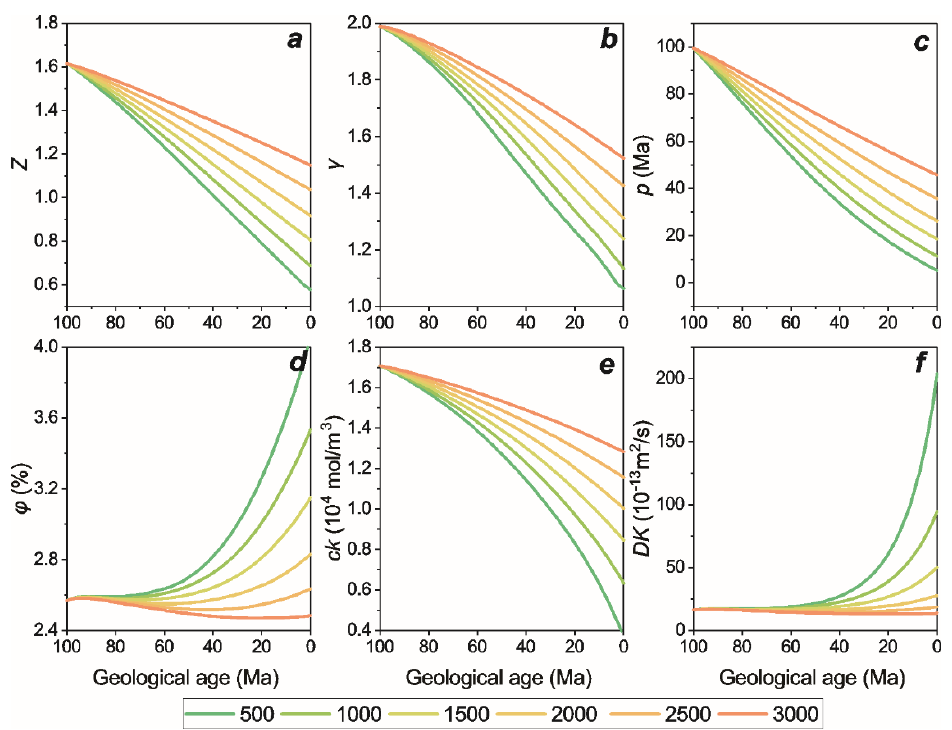
Figure 14. Evolution of compression coefficient ( a ), pressure coefficient ( b ), reservoir pressure ( c ), porosity ( d ), free gas concentration ( e ) and diffusion coefficient ( f ) for different lifting ranges ( HL ) of the CN well after uplift.